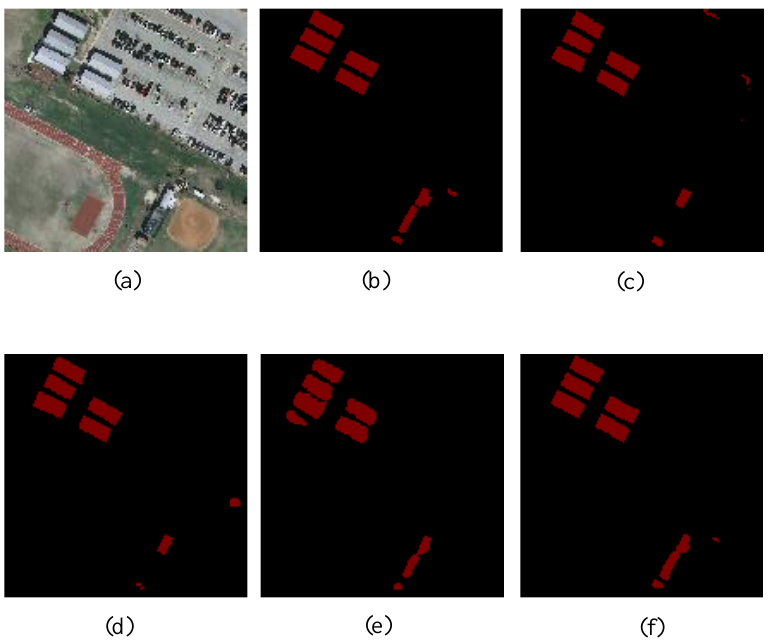
Figure 7. Comparison of reconstruction results using Inria aerial dataset. ( a ) the input image; ( b ) groud truth; ( c ) ResNet50 + ASPP; ( d ) ResNet50 + WASP(AVE); ( e ) LResNet50 + WASP(AVE); ( f ) Our method(LResNet50 + WASP(AVE) +